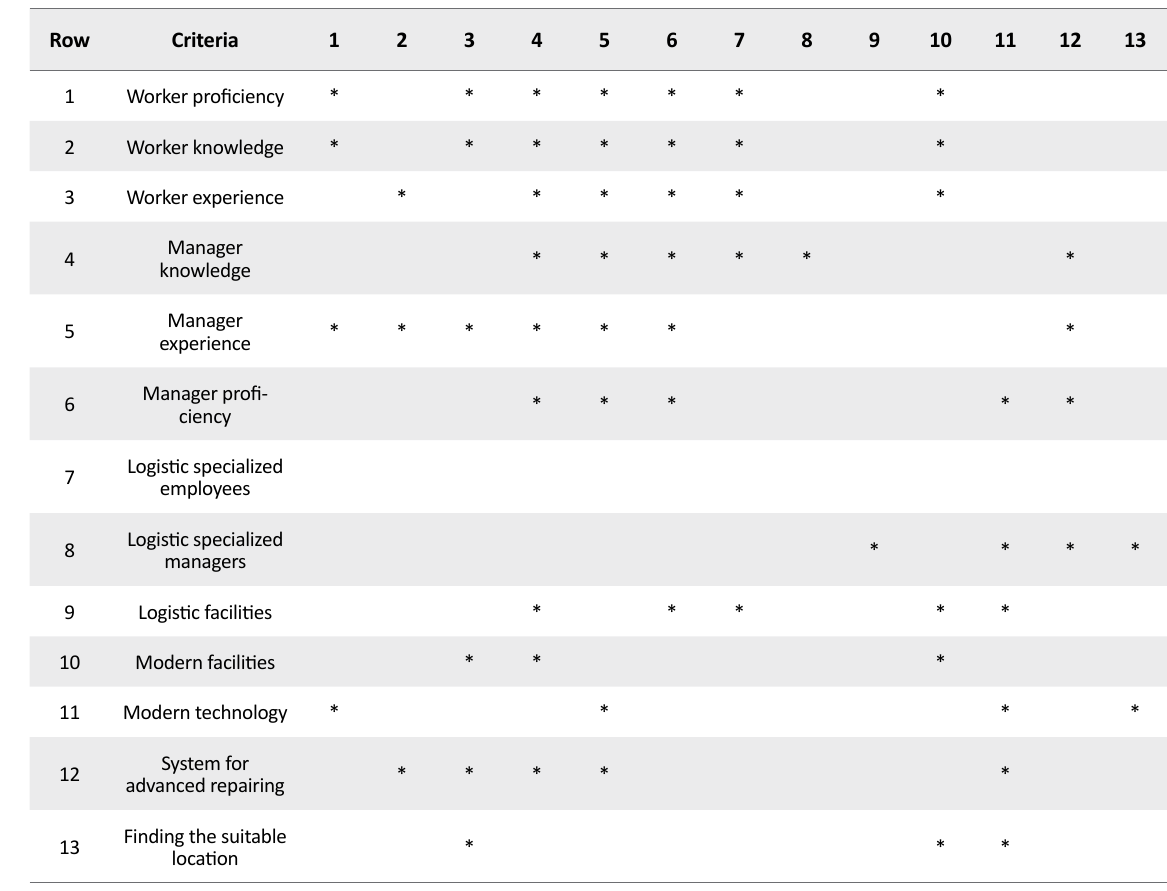
Table 4. The positive combined correlation (binary) of the sub-criteria of the health risk